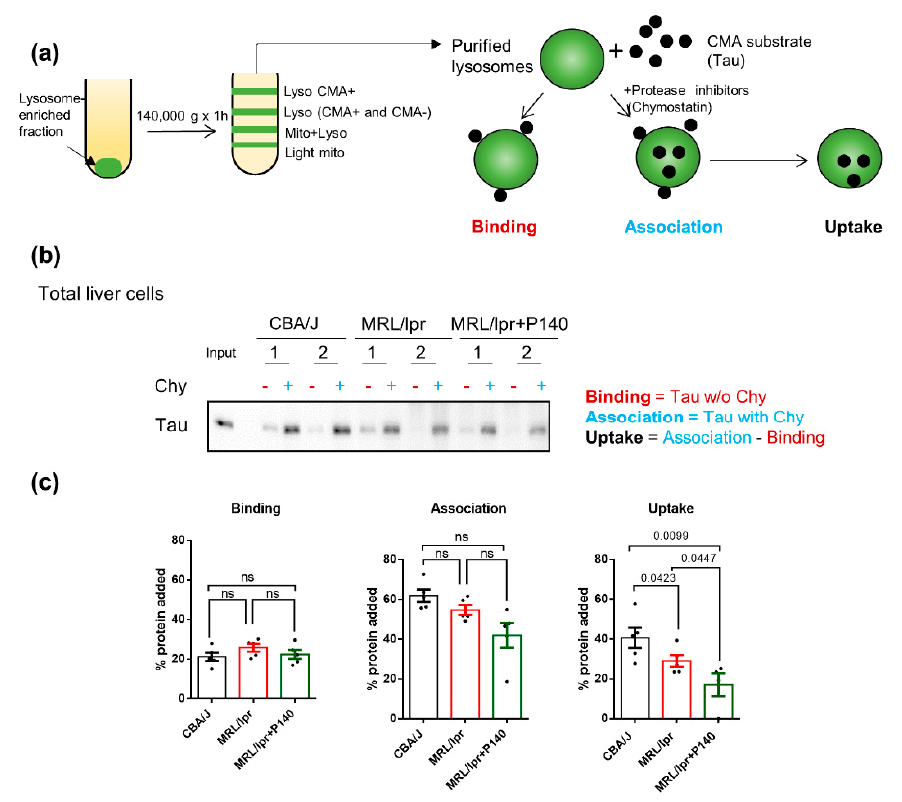
Figure 3. E ff ect of P140 peptide on the uptake of a prototypical chaperone-mediated autophagy (CMA) substrate into CMA-active lysosomal liver preparations. ( a ) Schematic presentation of purification of lysosomes and incubation assay to measure translocation of CMA uptake in vitro. Lysosome fractions with high ( + ) CMA activity were prepared from the liver of CBA / J, MRL / lpr and P140-treated MRL / lpr mice. Recombinant Tau protein (0.2 µ g) was added for 20 min at 37 ◦ C to lysosomes previously treated or not with the protease inhibitor chymostatin (chy; 100 µ M for 10 min at 0 ◦ C and diluted to a final concentration of 33 µ M). Samples were subsequently treated for analysis by SDS-PAGE and Western blotting. ( b ) Western blots of the levels of Tau recovered from CMA + lysosomes in the presence or not of chymostatin from the livers of CBA / J, MRL / lpr and P140-treated MRL / lpr mice. ( c ) Evaluation of the binding, association and uptake of Tau to CMA + lysosomes recovered from the livers of the three mice groups, by using densitometry of the blots shown in ( b ). Five samples (each represented by one point) were examined for each study group. Each point represents a sample pooled from 2–3 livers. One-way ANOVA Krustal-Wallis test was used to analyze the statistical significance. Error bars are ± SEM. ns means p values >